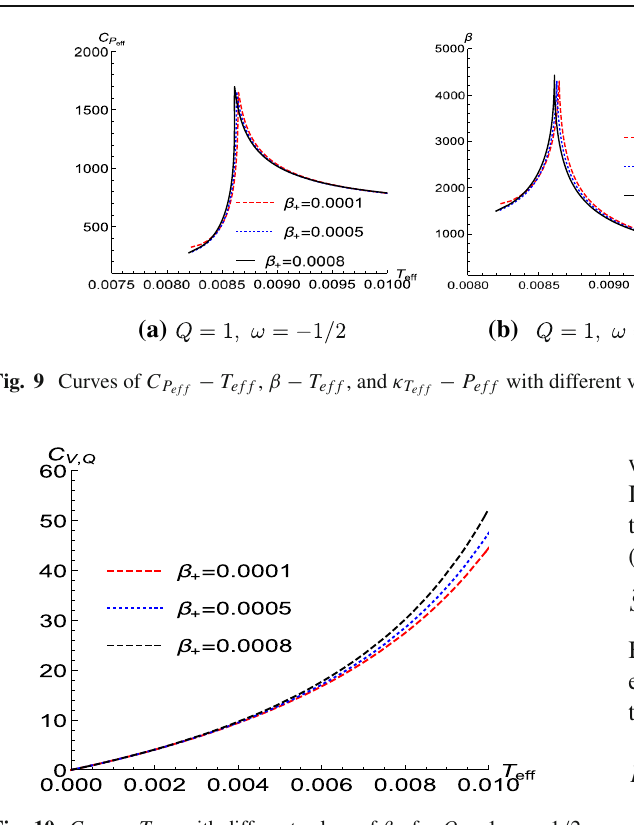
Fig. 10 C V , Q − T ef f with different values of β + for Q = 1, ω = 1 /